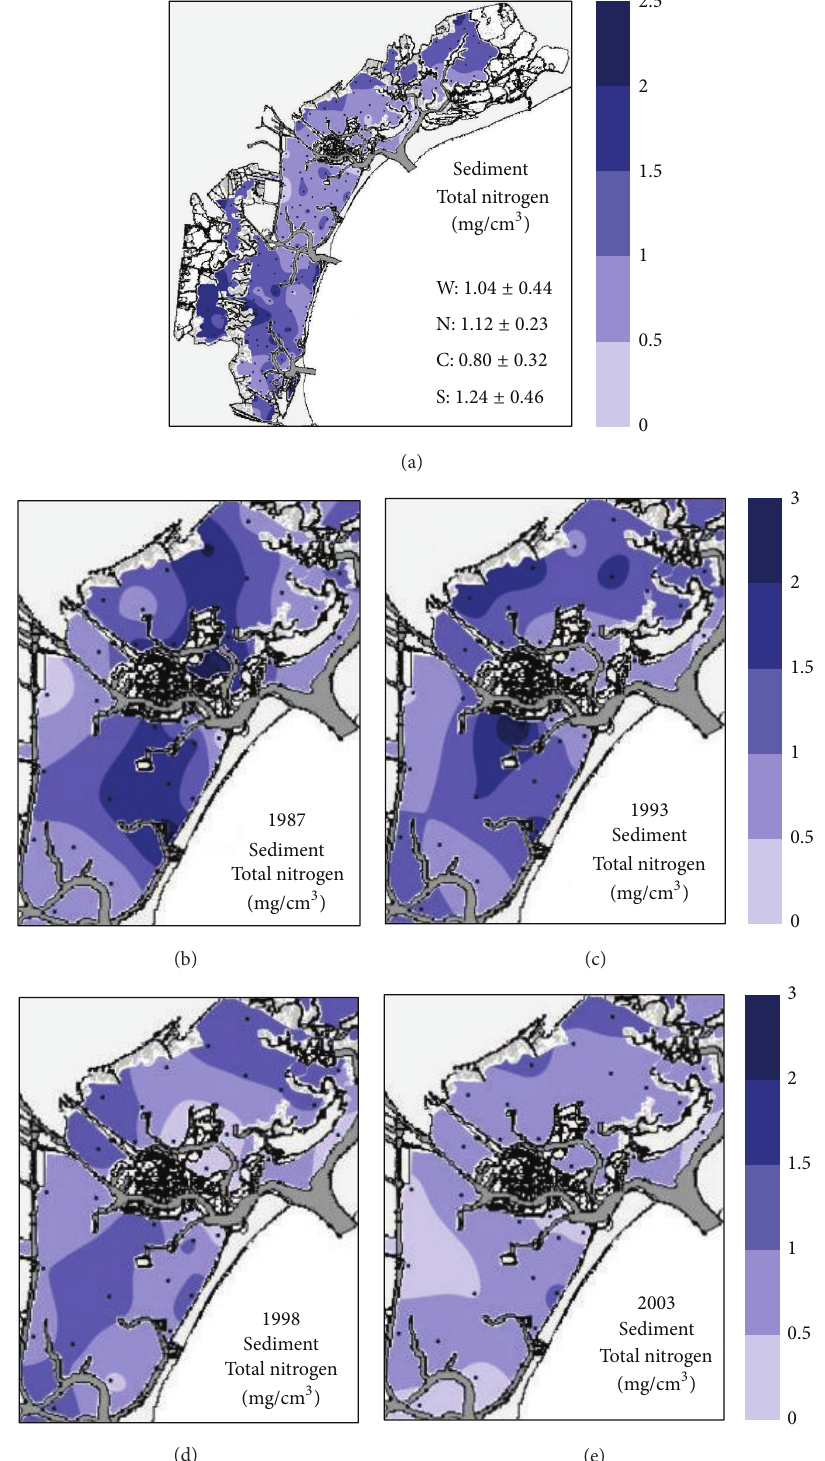
Figure 4: Spatial distribution of TN in 2003 (a). Mean values and standard deviations shown on maps for whole lagoon (W) and northern (N), central (C) and southern (S) basins. Other maps indicate distributions in 1987 (b), 1993 (c), 1998 (d), and 2003 (e) in central